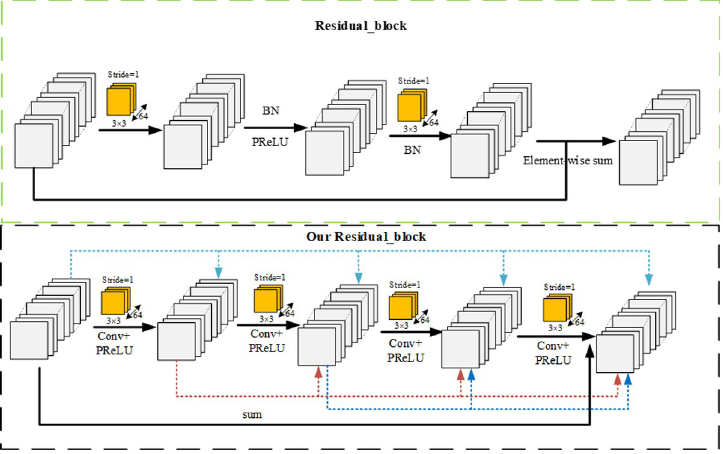
Fig 1. Residual block structure. Our Residual block replaces the BN layer of the original Residual block with a 3 × 3 convolution and PReLU activation layer; The upper part of the figure is the original residual block, and the lower part is our improved residual